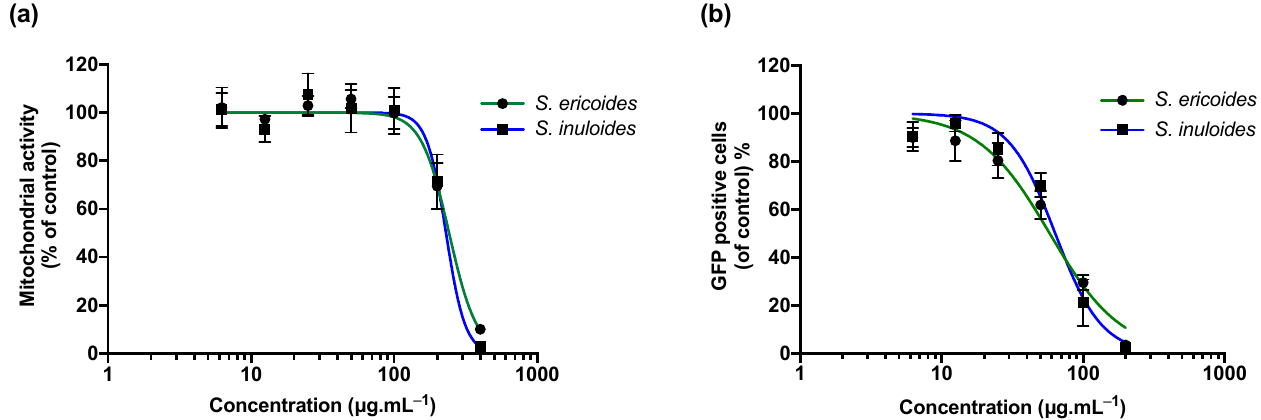
Figure 1. S. ericoides and S. inuloides extracts exert antiviral activity against ZIKV at non-cytotoxic concentrations. ( a ) A549 cells were treated with various concentrations of Stenocline extracts (400– 6.25 µg.mL − 1 ) for 48 h. The cellular metabolic activity was determined with a colorimetric MTT assay. ( b ) A549 cells were infected with ZIKV GFP at a Multiplicity Of Infection (MOI) of 2 and treated simultaneously with different concentrations (200–6.25 µg.mL − 1 ) of plants extracts for 24 h. The percentage of A549-infected cells was determined by flow cytometry. Each value is expressed relative to the mock-treated control and represents a mean + SD of three independent experiments conducted in triplicate.